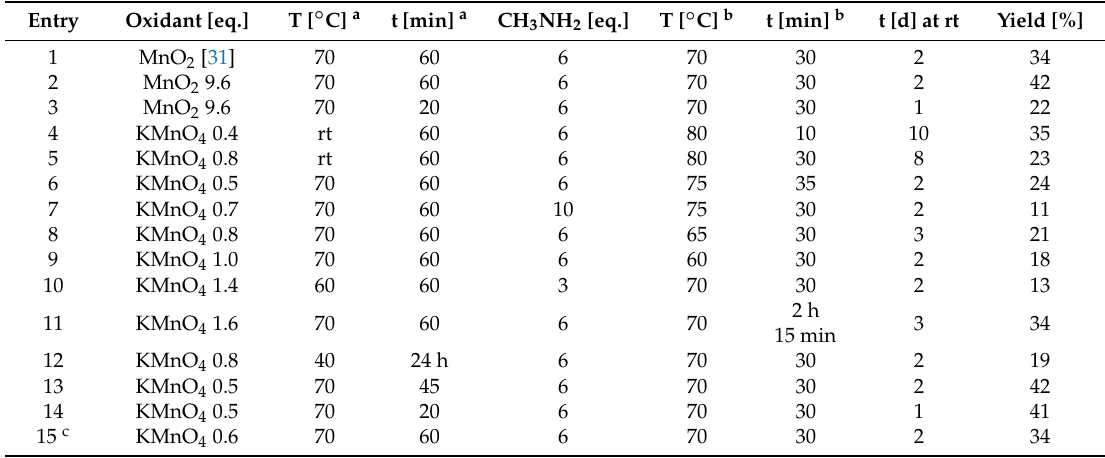
Table 5. Reaction conditions for the oxidation/imination of PN.